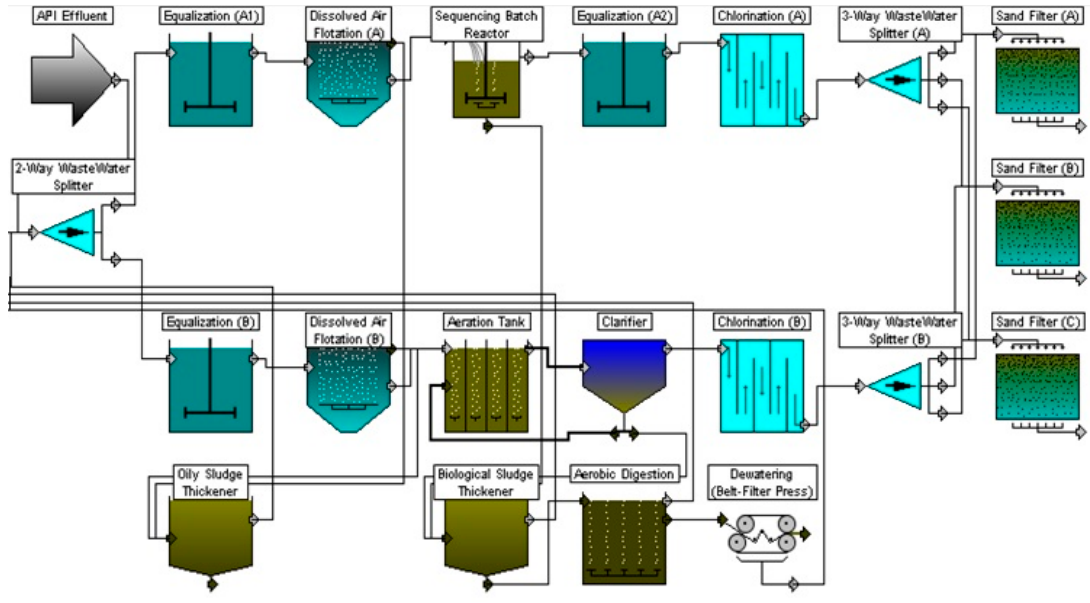
Figure 2. Process flow diagram of the petroleum refinery wastewater treatment plant (PRWWTP) containing sequencing batch reactor (SBR) + CAS processes. Table 4. The characteristics of SBR process